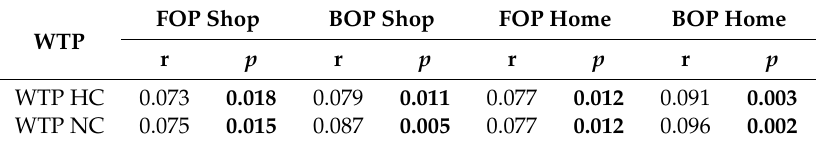
Table 18. Pearson correlation coe ffi cients of reading food labels with the willingness to pay more for food products with health and nutrition claims compared to conventional